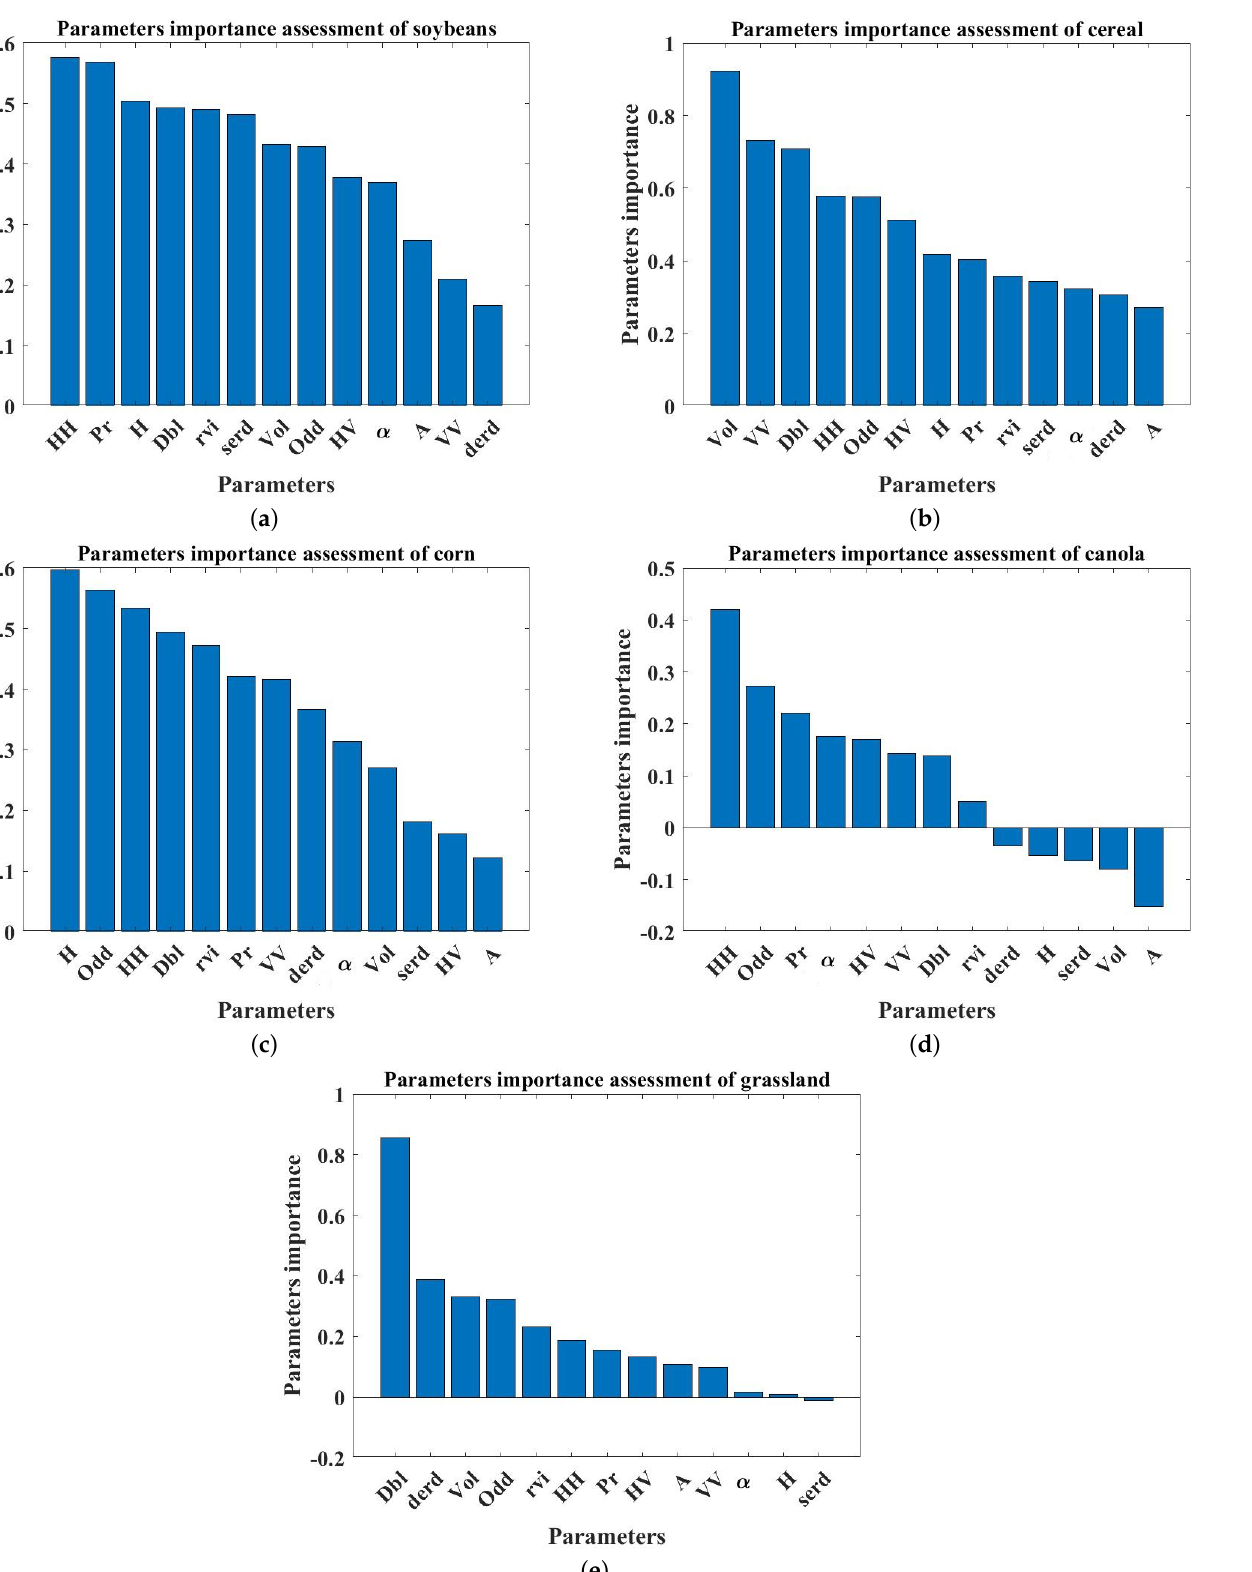
Figure 7. Importance of the polarimetric parameters and backscattering coefficients for estimated SSM. ( a ) Importance of the parameters for estimated SSM in soybeans; ( b ) Importance of the parameters for estimated SSM in cereal; ( c ) Importance of the parameters for estimated SSM in corn; ( d ) Importance of the parameters for estimated SSM in canola; ( e ) Importance of the parameters for estimated SSM in